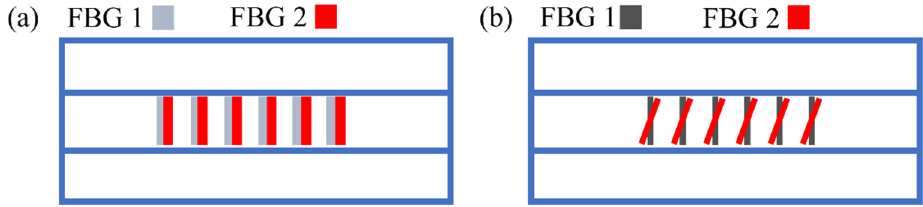
Figure 14. ( a ) The schematic diagram of the strain-assistant structure. ( b ) The schematic diagram of the tilt-assistant